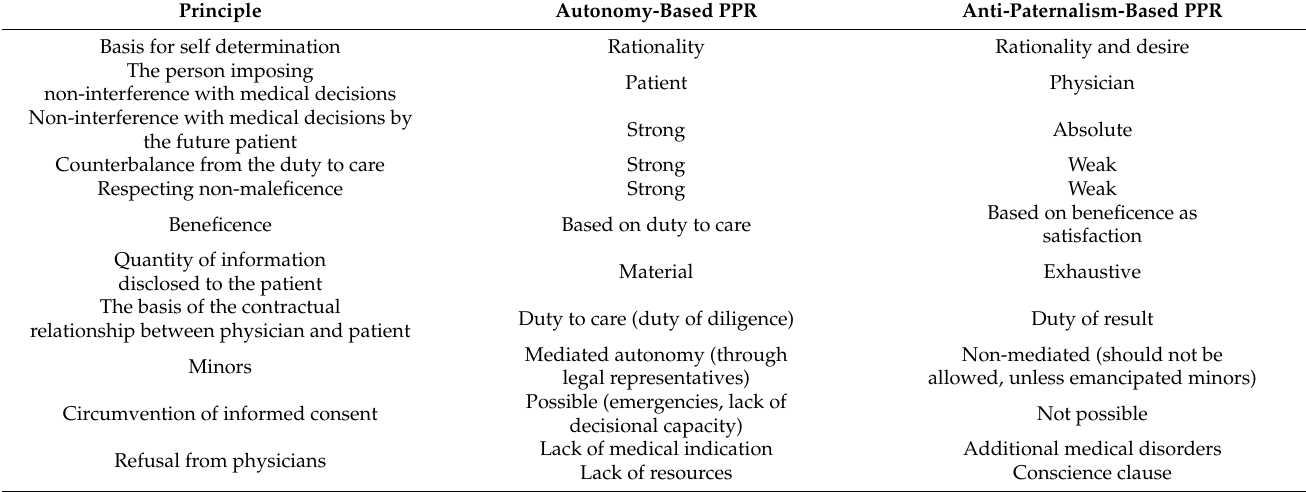
Table 1. Differences between autonomy and anti-paternalist models of